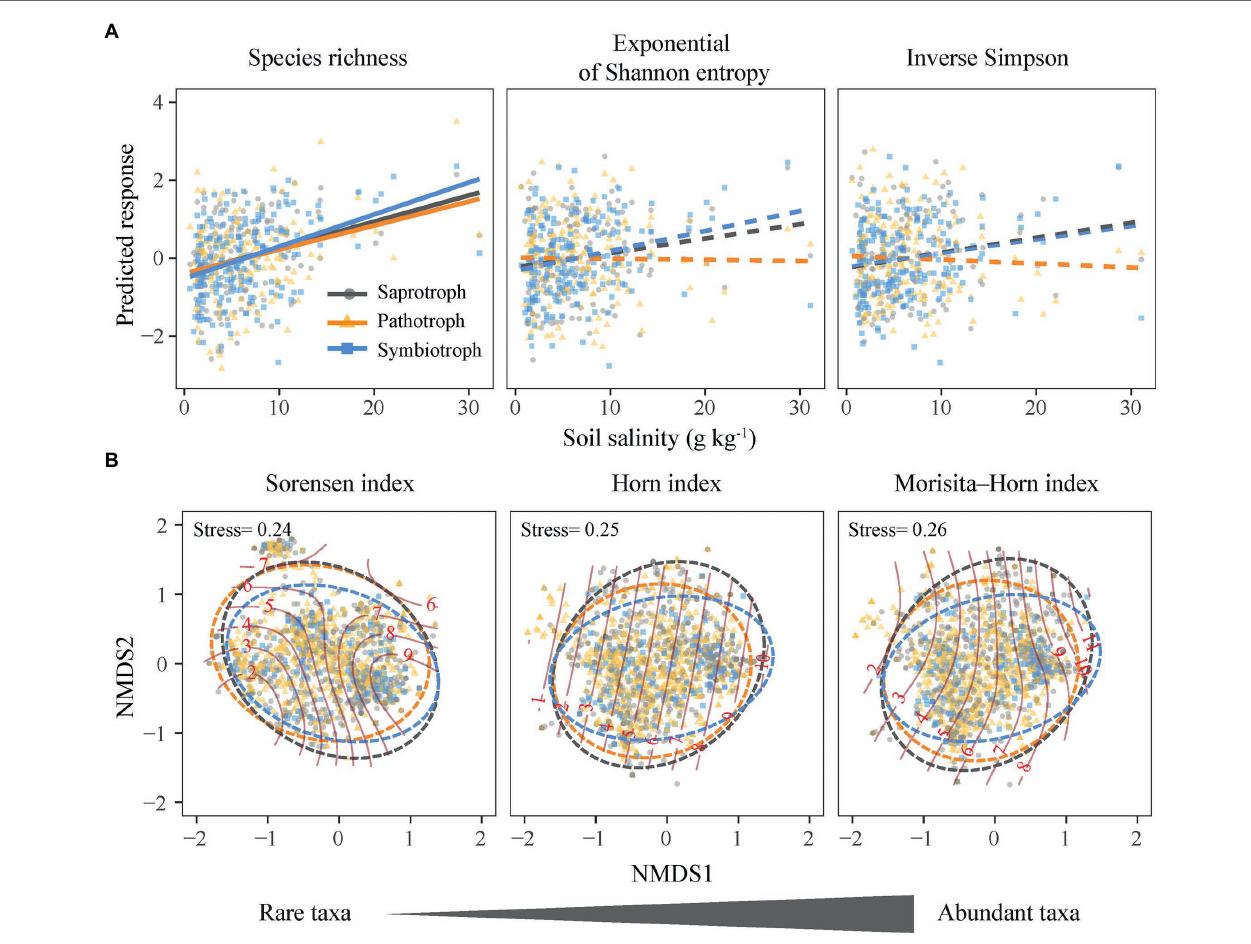
FIGURE 3 | Relationships between the community structure of functional guilds of soil fungi and soil salinity. (A) Alpha diversity; lines are derived from the linear mixed effects models and solid and dashed lines denote significant and insignificant regression coefficients, respectively. (B) Community composition; solid lines denote salinity gradients and dashed lines denote 0.95 confidence